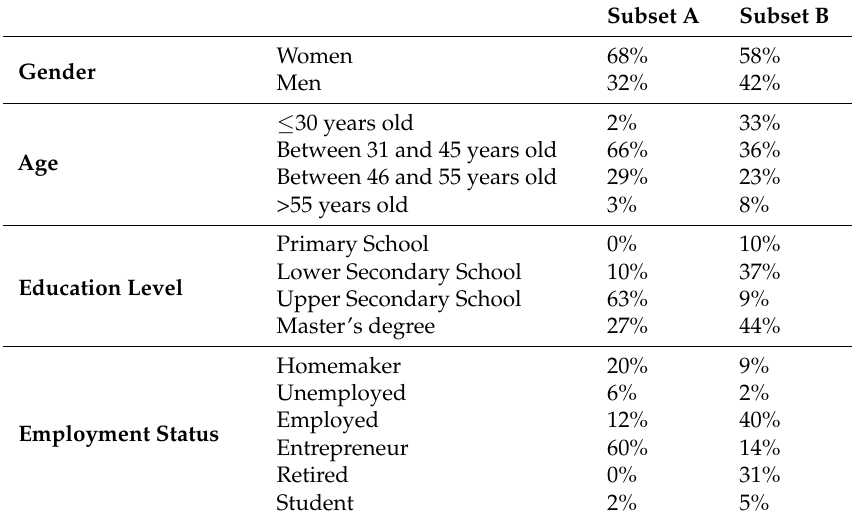
Table 3. Socio-demographic characteristics of the subsets A and